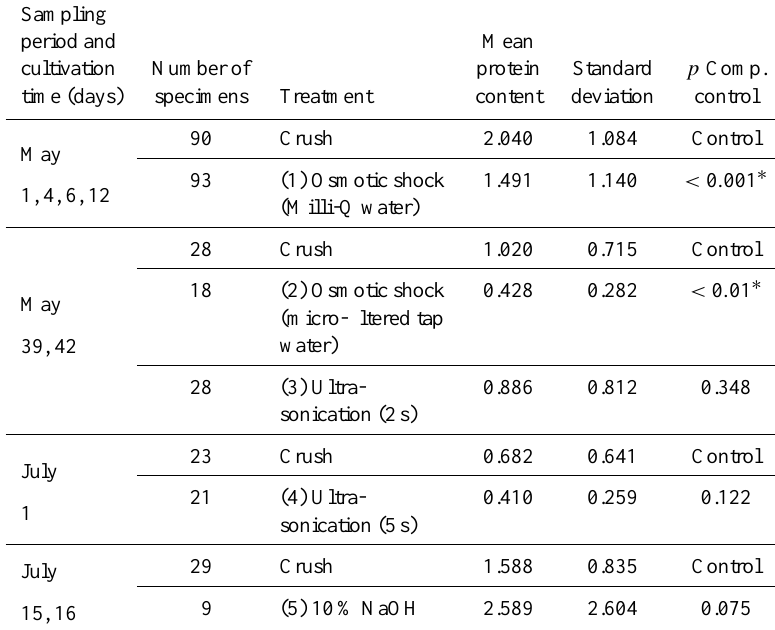
Table 5. Comparison of protein concentrations analysed with different preparation methods. Protein concentrations are compared within each experiment, and not between experiments. Specimens with no measurable protein content were interpreted as dead and data were not further used. The mean protein content of all individuals is given along with the standard deviation. The probability ( p ) is associated with the variance analysis comparing each treatment to the control (crushed individuals). Values marked with an asterisk ( ∗ ) are significantly different from the control group of crushed individuals. Sampling period and Mean cultivation Number of protein Standard p Comp. specimens